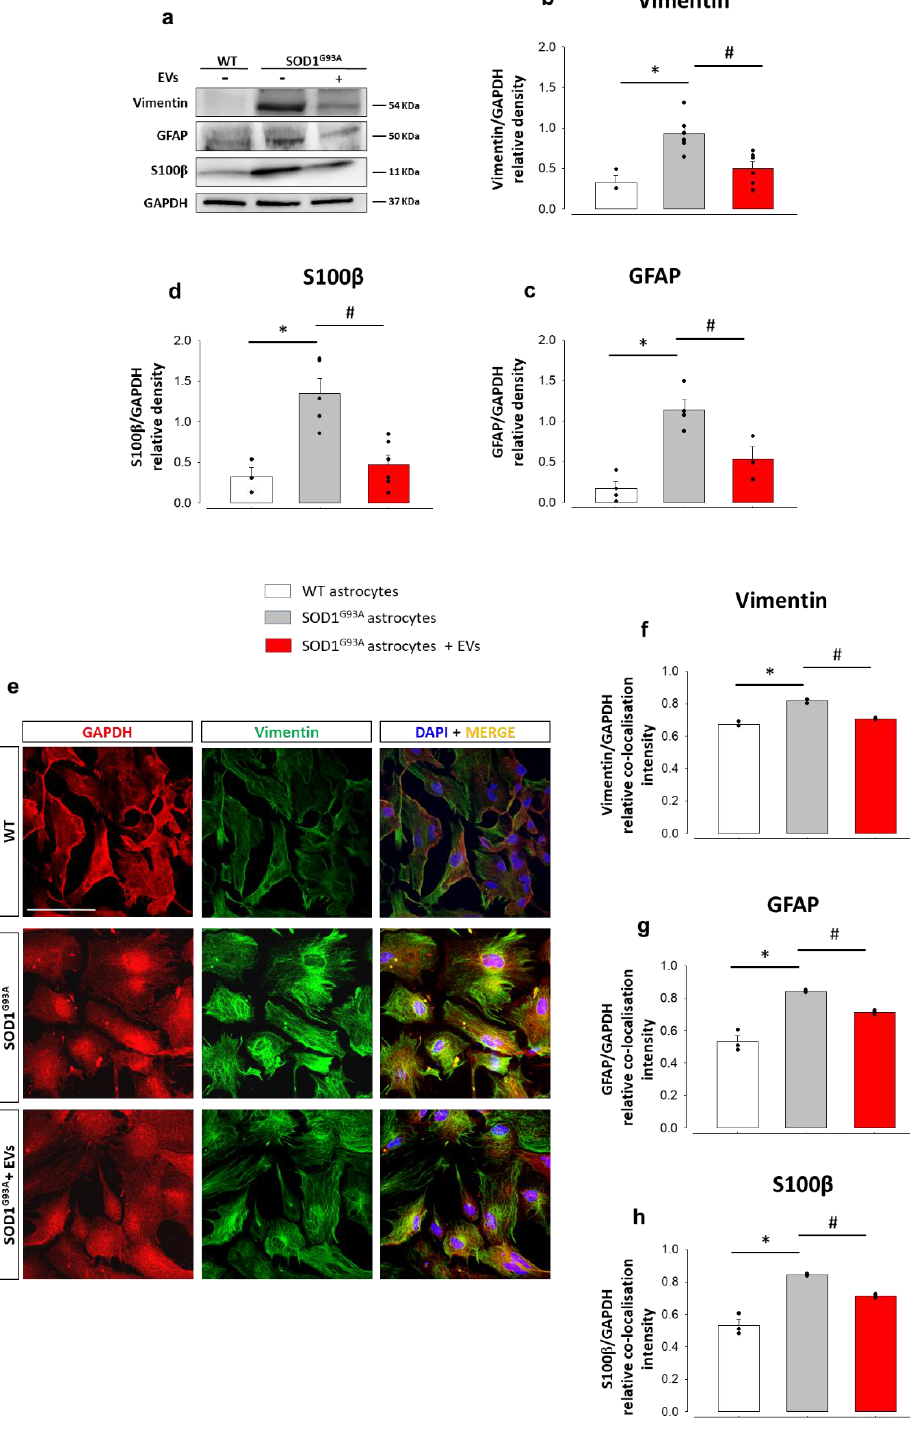
Figure 2 . MSC-derived EVs reduce astrogliosis in astrocytes from the spinal cords of adult SOD1 G93A mice. ( a ) Representative Western blots (WB) of immunoreactive bands for vimentin, GFAP, and S100 β ; ( b – d ) quantitative representation of WB densitometric expression signals for ( b ) vimentin, ( c ) GFAP, and ( d ) S100 β normalized to glyceraldehyde 3-phosphate dehydrogenase (GAPDH), as housekeeping protein, in WT astrocytes, untreated SOD1 G93A astrocytes, and SOD1 G93A astrocytes treated for 24 h with MSC-derived EVs. Vimentin, GFAP, and S100 β expression are sig- nificantly increased in untreated SOD1 G93A astrocytes vs. WT astrocytes (F (2,12) = 10.998, p = 0.004; F (2,8)